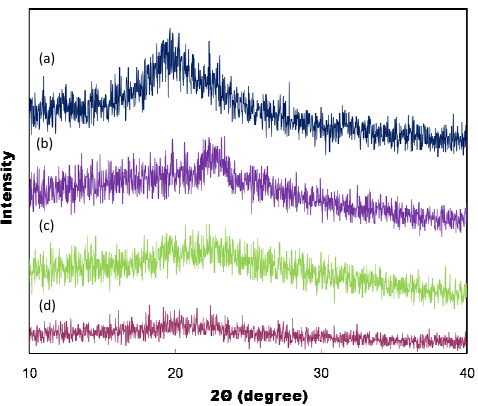
Figure 2. XRD graphs of ( a ) QPVA; ( b ) QPVA/5% FS; ( c ) QPVA/10% FS and ( d ) QPVA/20% FS.